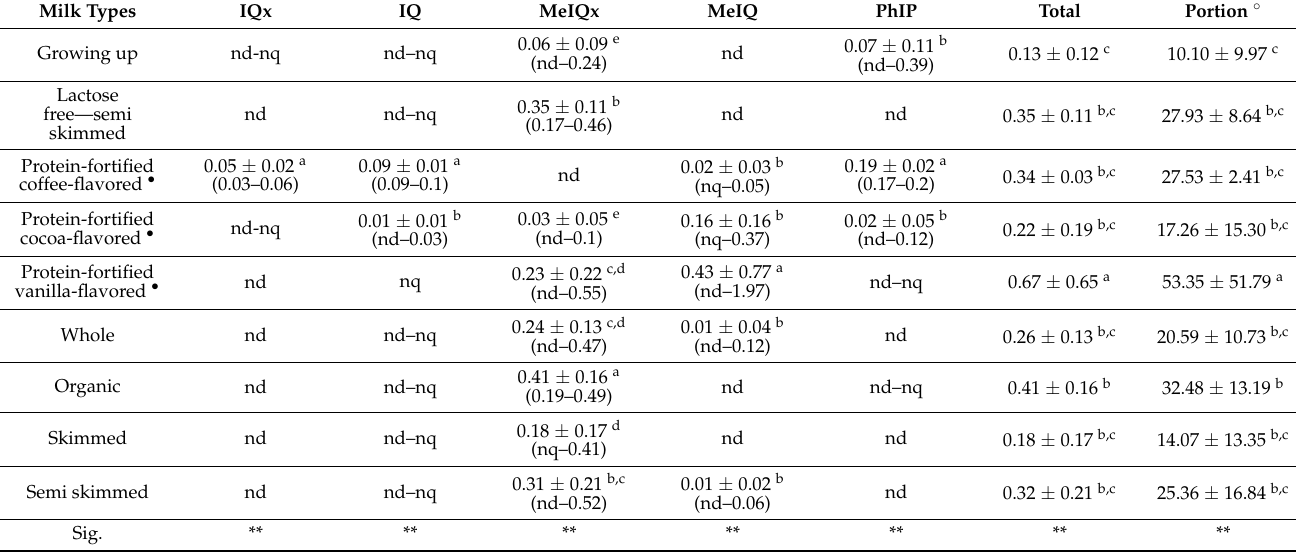
Table 6. The amount (ng) of total and individual heterocyclic aromatic amine contents quantified in 2.5 mL milk (mean ± SD). Milk